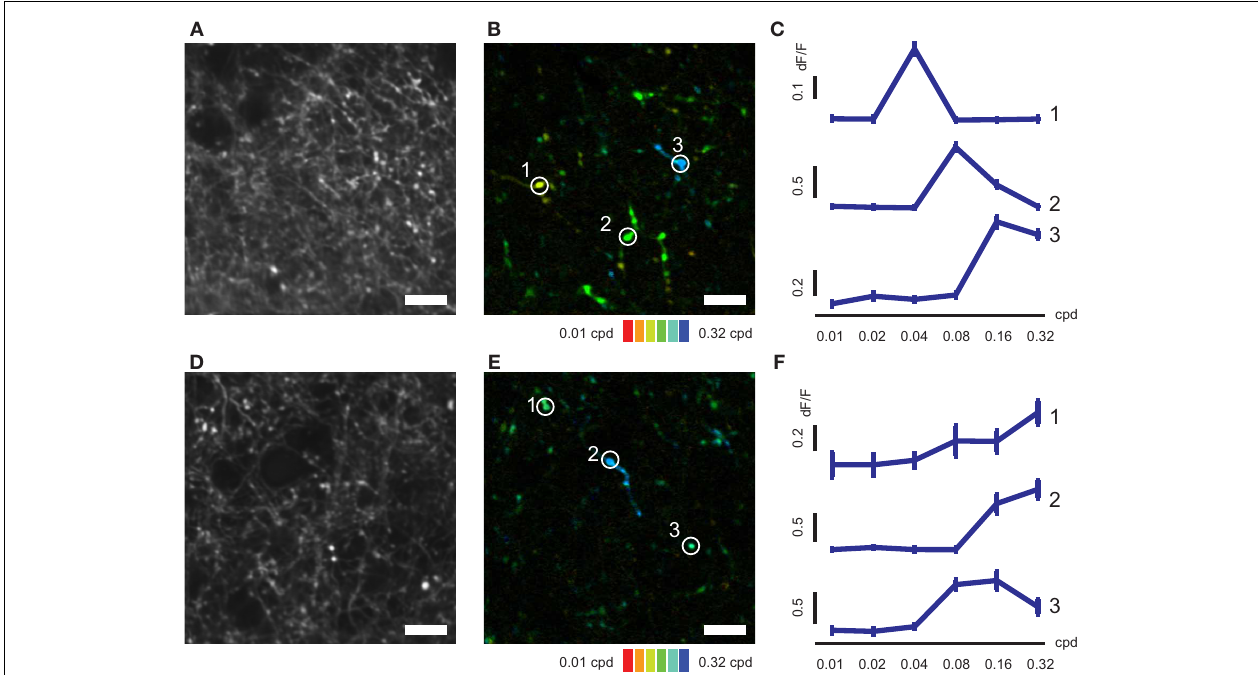
FIGURE 4 | SF-tuned responses of axonal boutons in AL and LM. (A) Representative FOV in LM. (B) Color-coded map of preferred SF of axonal boutons shown in (A) . (C) Representative SF tuning curves for three axonal boutons indicated by circles in (B) . (D) Representative